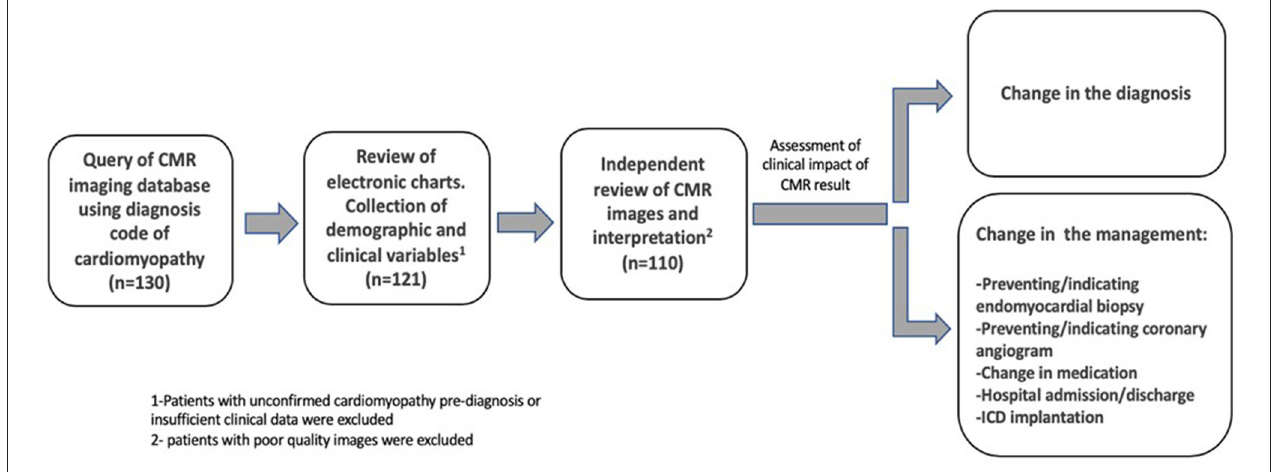
FIGURE 1 | Algorithm of study design: cohort selection.